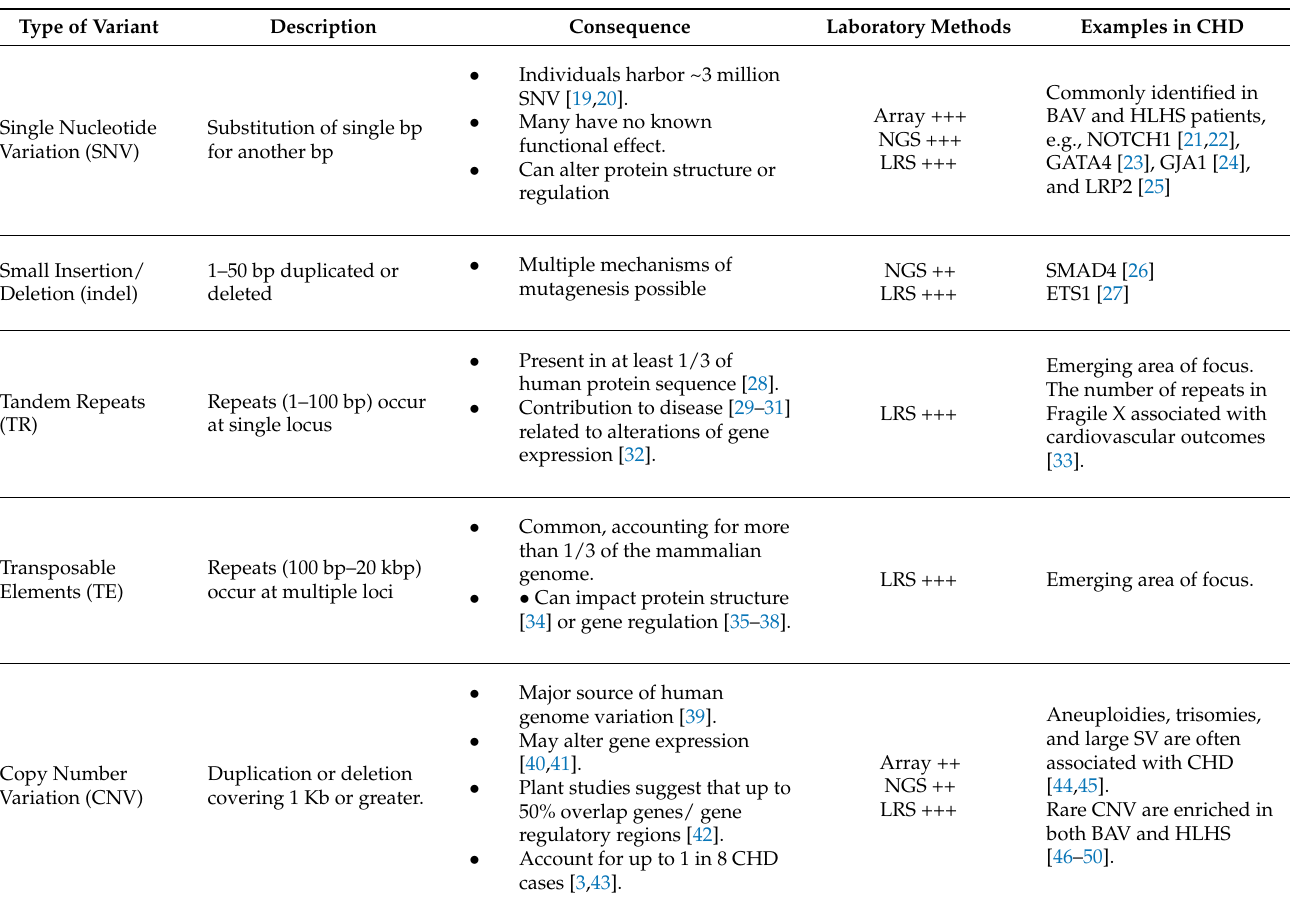
Table 2. Characteristics of types of genetic